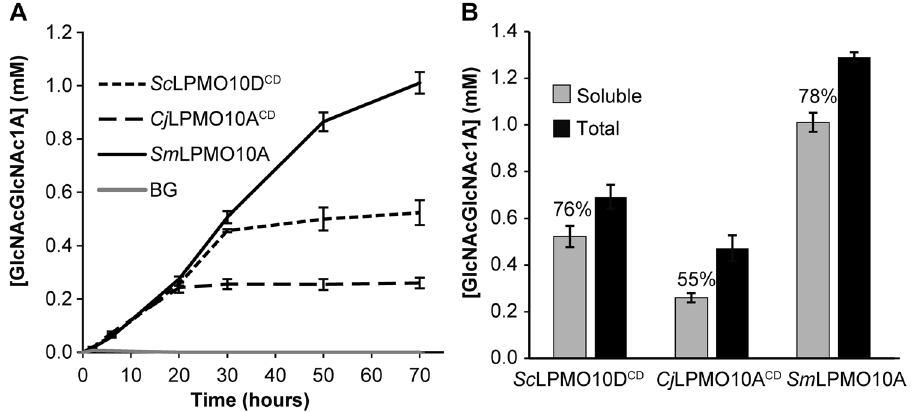
Figure 5. Time course of β-chitin degradation. Reactions with 1 µM LPMO ( Sc LPMO10D CD , Cj LPMO10A CD or Sm LPMO10A) were incubated with 10 g/L β-chitin at 40 °C and pH 6.0 in the presence of 1 mM ascorbic acid (reducing agent) for 70 h. At various time points samples were taken and the reactions were stopped by vacuum filtering, after which the soluble oxidized products were converted to oxidized dimers via treatment with chitobiase ( Sm CHB) prior to analysis. Panel B shows the solubilized oxidized products versus the total amount of oxidized sites in the reaction mixtures after 70 h of incubation. The total amounts of oxidized sites were determined by incubating the LPMO-treated sample at 98 °C for 10 min followed by an overnight incubation with a chitinase cocktail (2 µM Sm Chi18A, 2.5 µM Sm Chi18C, and 1 µM Sm CHB) at 37 °C, after which oxidized chitobiose was analyzed. The degree of solubilization in percentage is shown in the figure and the total amount of oxidized sites correspond to 100%. All reactions were performed in triplicates. The error bars show ± S.D. (n = 3).